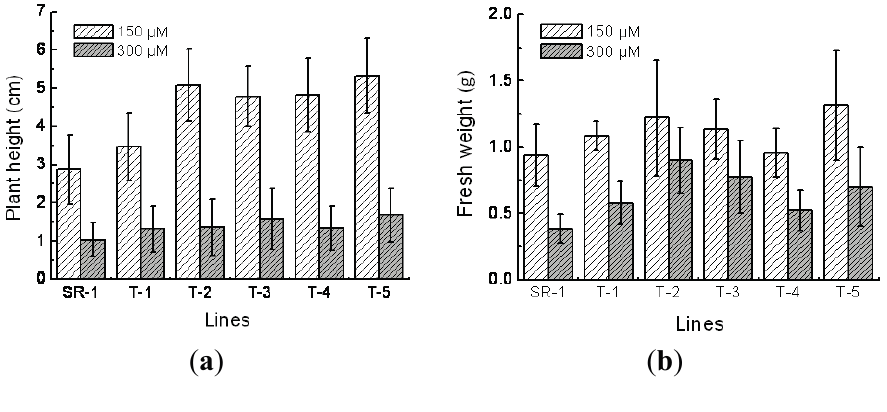
Figure 4. Comparison of plant height ( a ) and fresh weight ( b ) between transgenic and non-transgenic tobacco plants. SR-1, non-transgenic tobacco; T-1 to T-5, transgenic tobacco. Mean values and standard deviations were calculated based on six